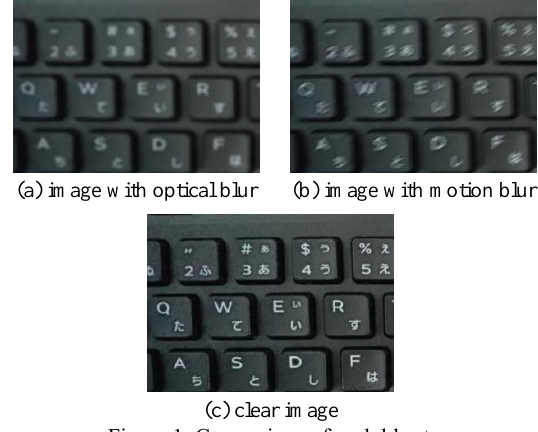
Figure 1. Comparison of each blur